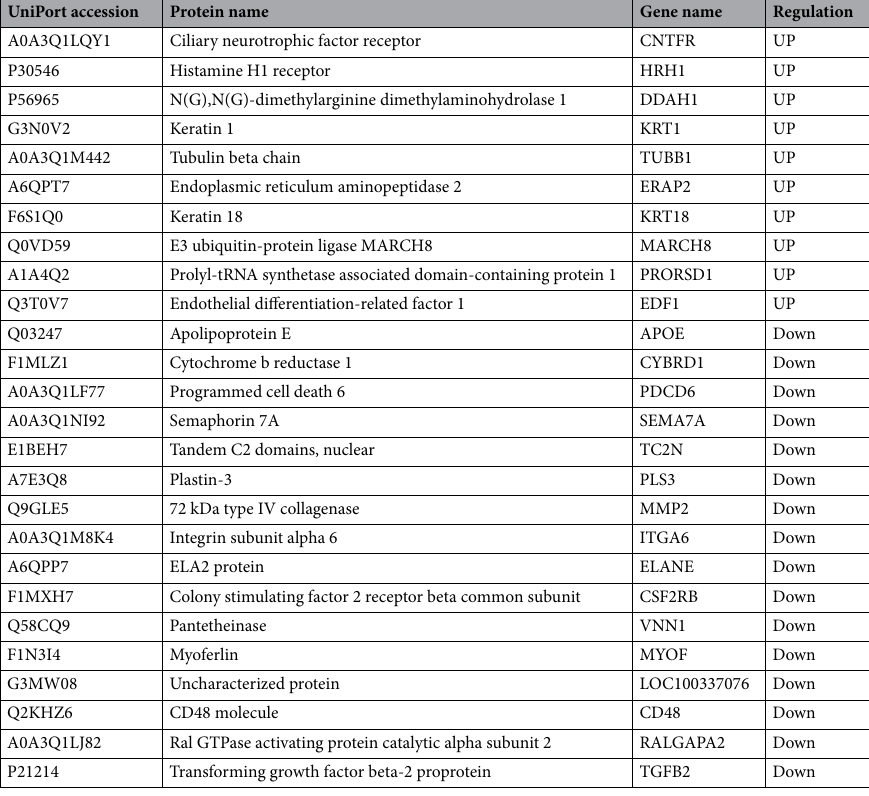
Table 3. The candidates for differentially expressed proteins in milk sEV from BLV-infected